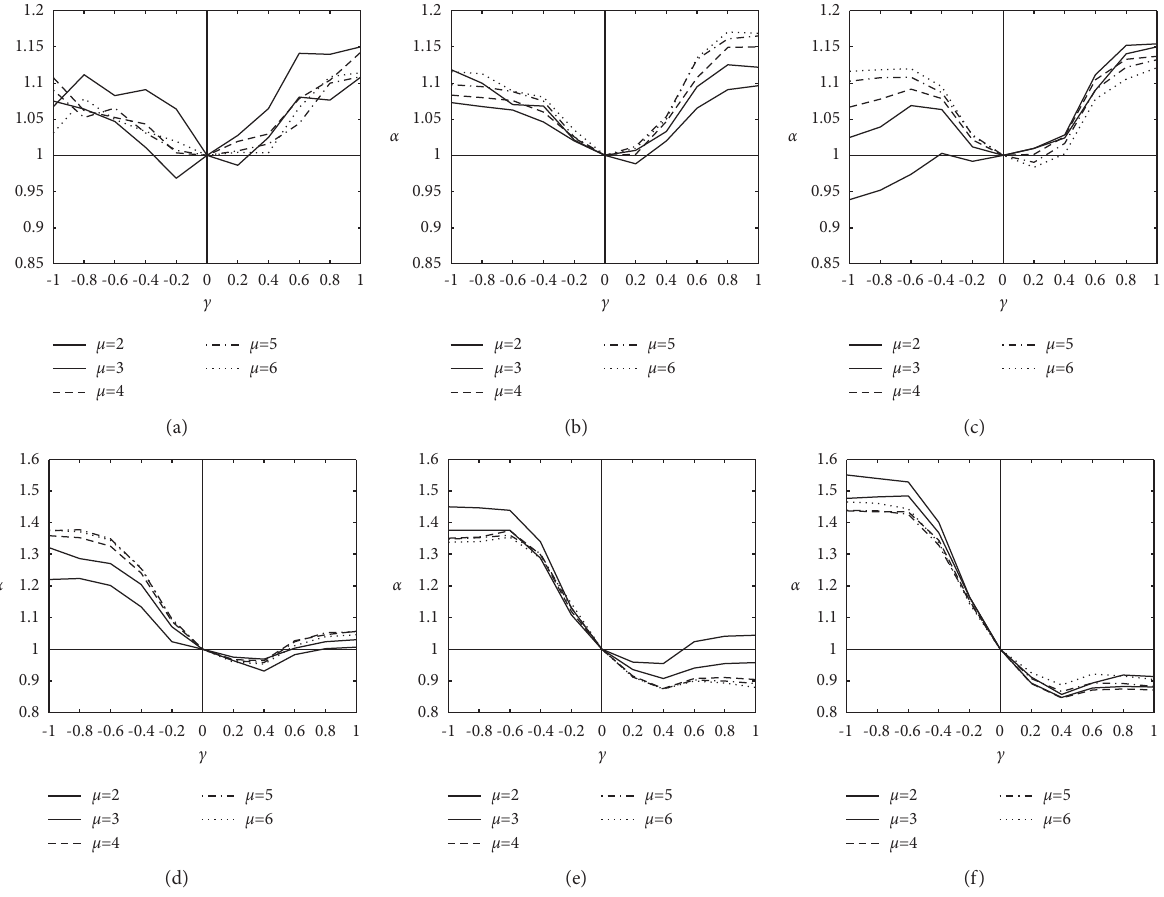
Figure 8: The curves of α of constant ductility factors for soft soil site. (a) T � 0–0.5s. (b) T � 0.5–1.0s. (c) T � 1.0–2.0s. (d) T � 2.0–3.0s. (e) T � 3.0–4.0s. (f) T � 4.0–5.0